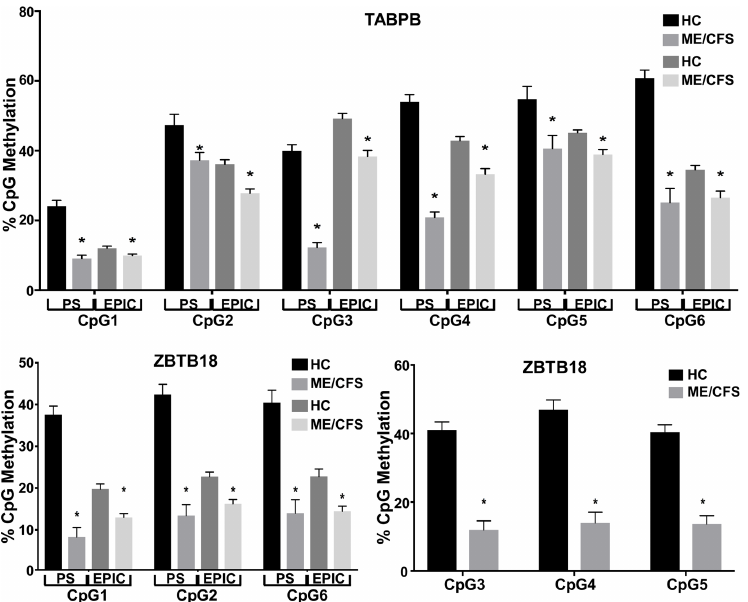
Fig 7. Bisulfite-conversion followed by pyrosequencing (PS) validation of DMPs identified by Illumina MethylationEPIC microarrays (EPIC). Average methylation level of CpG sites within promoters of TABPB and ZBTB18 were assessed using pyrosequencing. Corresponding probes for TABPB: CpG1—cg04415168 (TSS1500), CpG2—cg10376053 (TSS1500), CpG3—cg14288848 (TSS1500), CpG4—cg17055704 (TSS1500), CpG5—cg14473643 (TSS1500), CpG6—cg14309283 (TSS1500). Corresponding probes for ZBTB18: CpG1—cg16399365 (TSS1500), CpG2 —cg15896892 (TSS1500), CpG6—cg19698993 (TSS1500). CpG3, CpG4 and CpG5 are not printed on the Illumina MethylationEPIC microarrays and are located in ZBTB18 promoter between CpG2 and CpG6. (cid:3) = FDR (cid:20) 0.05 for EPIC; (cid:3) = p (cid:20) 0.05 for PS. Error bars represent the standard error of the